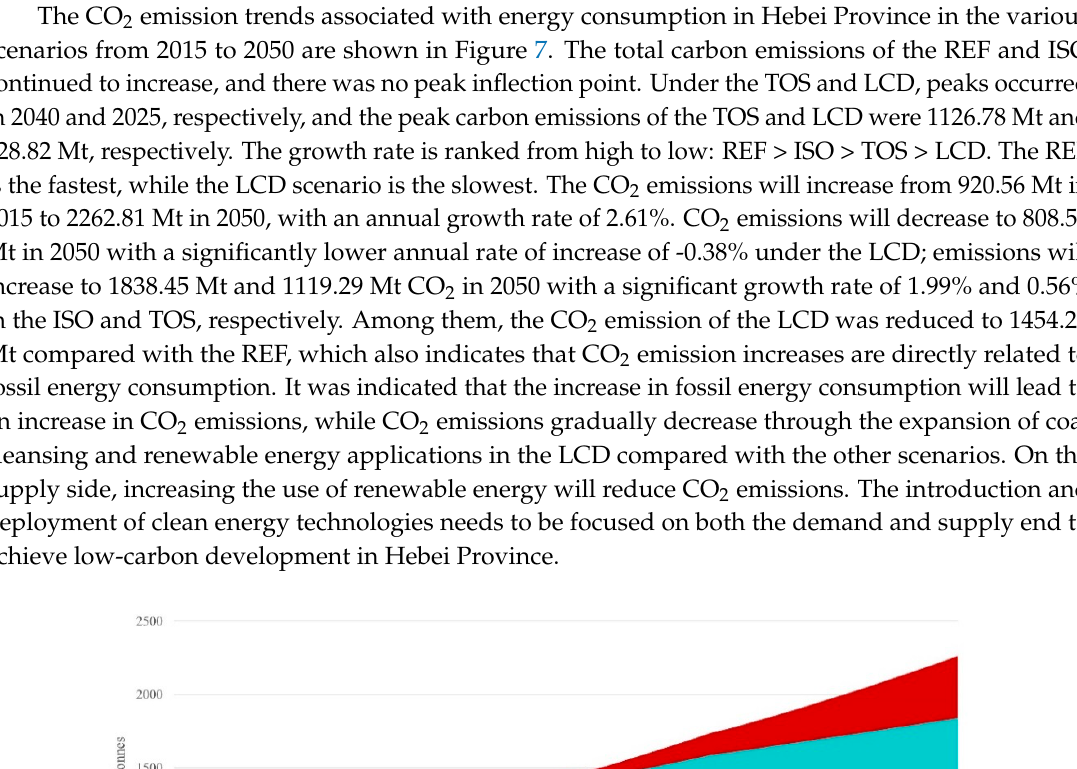
Figure 8. The proportion of CO 2 emissions in each sector. 5. Discussion 5.1. Uncertainty of the Scenario Analysis Results A series of parameters according to the 13th five-year plan was applied in this study. The LEAP model is adopted to predict the energy consumption, and the CO 2 emission factor was referenced